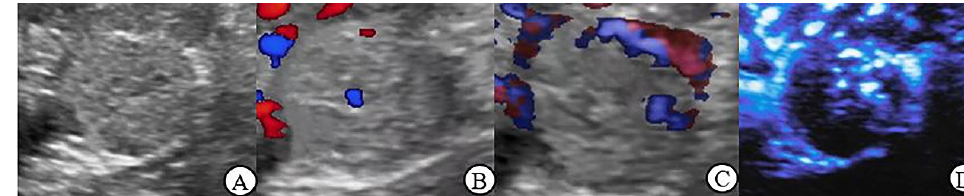
Figure 2. Clear cell carcinoma (largest diameter: 2.1 cm) ( A ): Gray scale ultrasound: the mass with clear boundary, hypoechoic, and the internal echogenicity was heterogeneous; ( B ): CDFI: 1 dotted blood flow signal was observed in the lesion, Adler Grade 1; ( C ): PDI: 4 dotted blood flow signal was observed in the lesion, Adler Grade 2; ( D ): MFI: rich dotted was observed in the lesion, Adler Grade 3, peripheral annular blood flow was recorded.